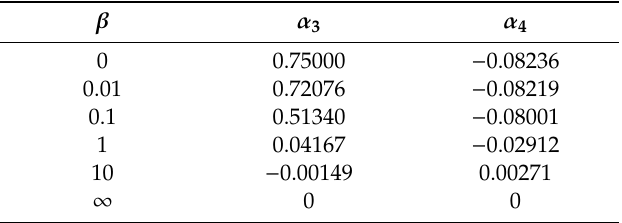
Table 1. The particle velocity correction coe ffi cients α 3 and α 4 in Equation (20) calculated from Equations (56) and (57) as functions of the polarization parameter β .